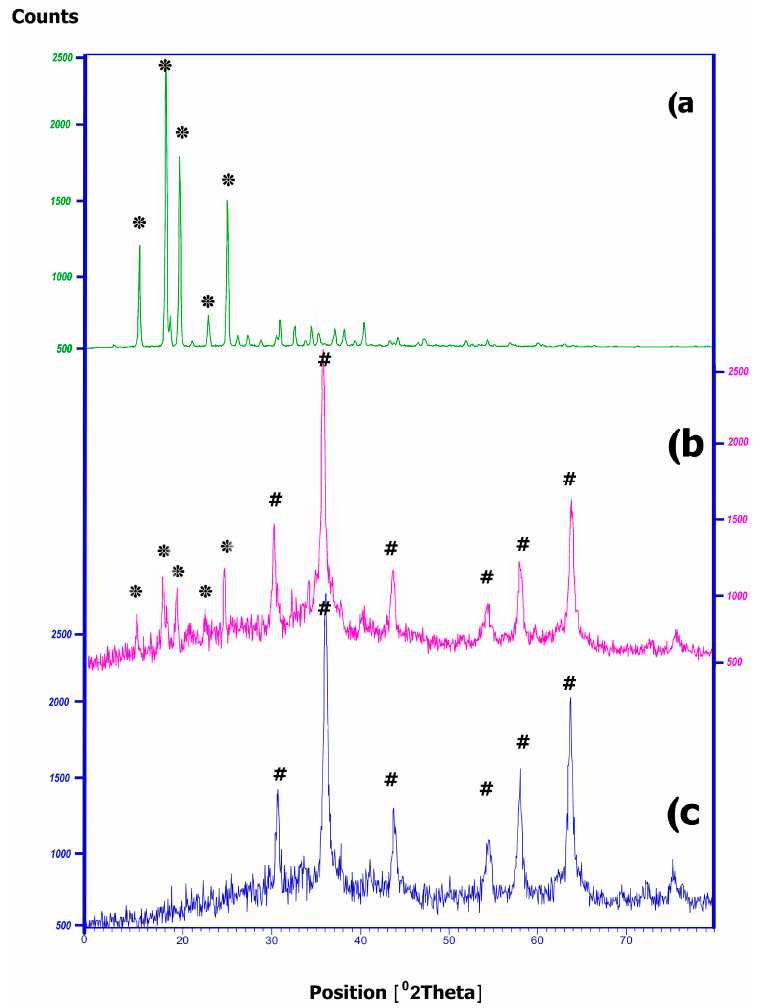
Figure 4. XRD patterns of pristine L -proline ( a ), GO/Fe 3 O 4 / L -pro ( b ), and GO/Fe 3 O 4 ( c ). Symbles # and * refer to Fe 3 O 4 NPs and L-proline patterns respectively.